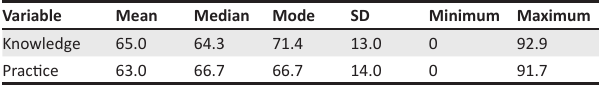
TABLE 3: Total scores for knowledge and practice ( % ). Variable